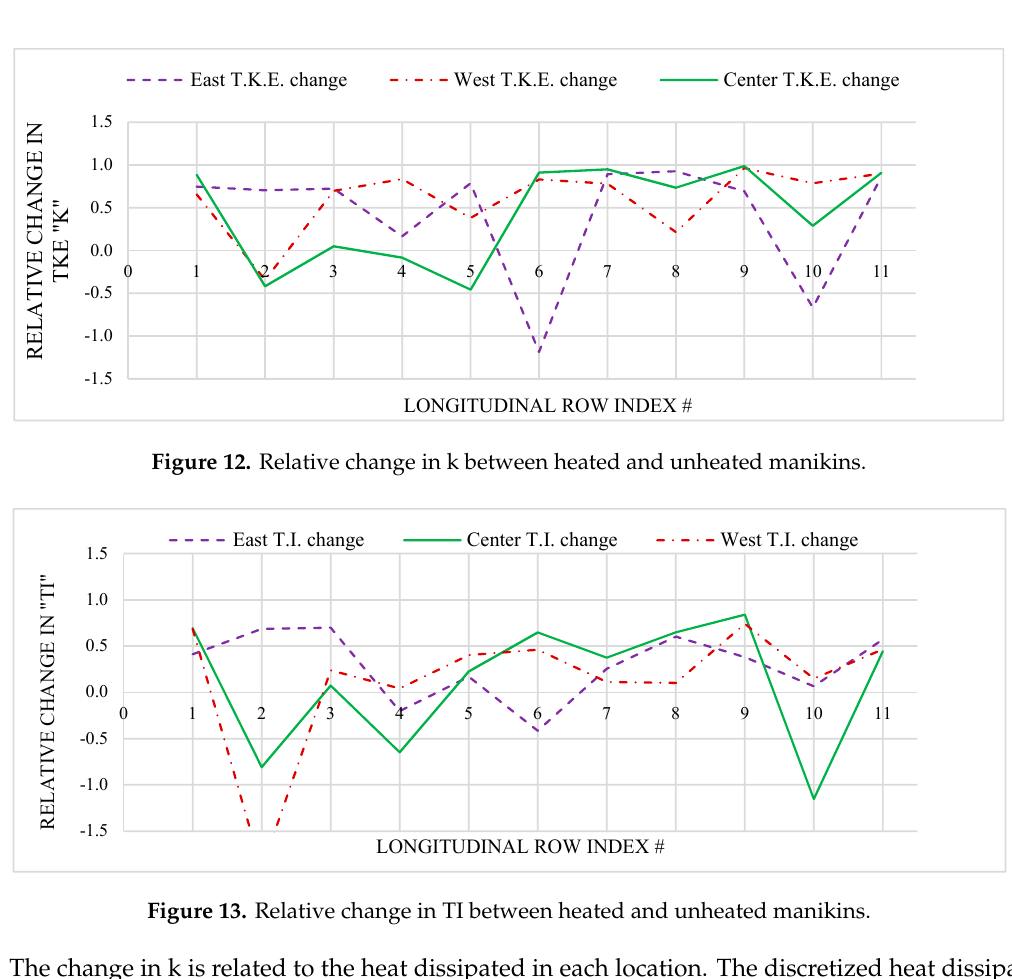
for heated and unheated cabins were evaluated using three transducers separated by a distance of 12.7 cm and utilizing Equation (9). The relative change in the dissipation rates with unheated manikins over heated cases were calculated using Equation (11) and the results are shown in Figure